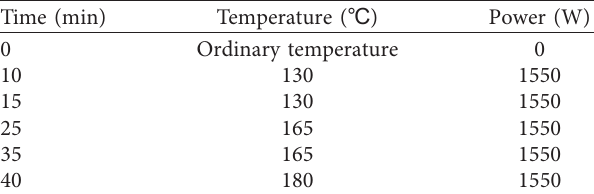
Table 2: Microwave operating conditions for the digestion of